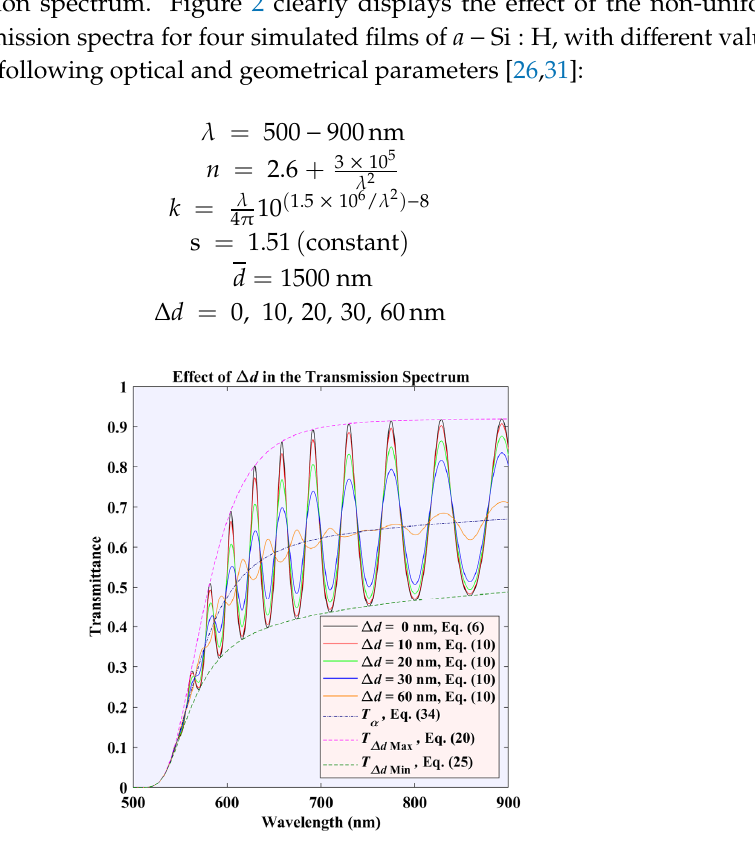
Figure 2. Numerical integration of Equation (6) for transmission, for five different values of the wedging parameter Δ d (see the text for more details).